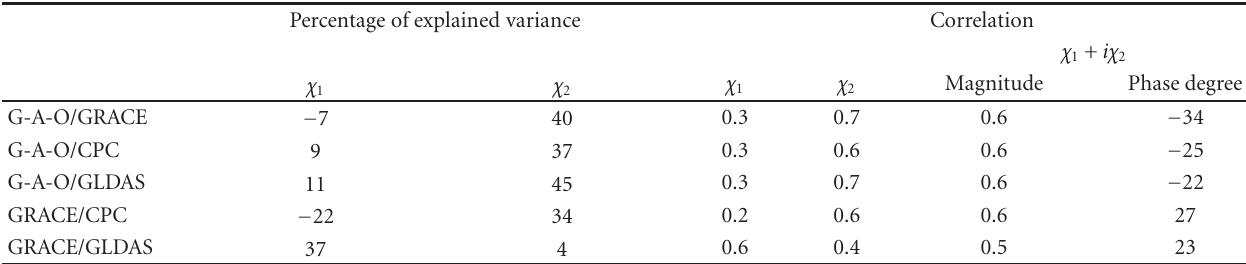
Table 2: Correlations between the polar motion interannual variations estimated from geodetic residuals, GRACE solutions, and CPC and GLDAS hydrological models. Correlation values are better for χ 2 than χ 1 . This discrepancy is possibly caused by errors of the oceanic model removed from the geodetic observations.